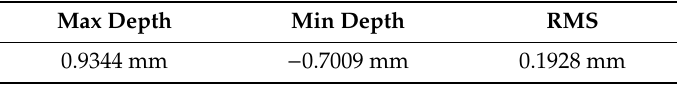
Table 10. The analysis result of the repaired artificial rail.